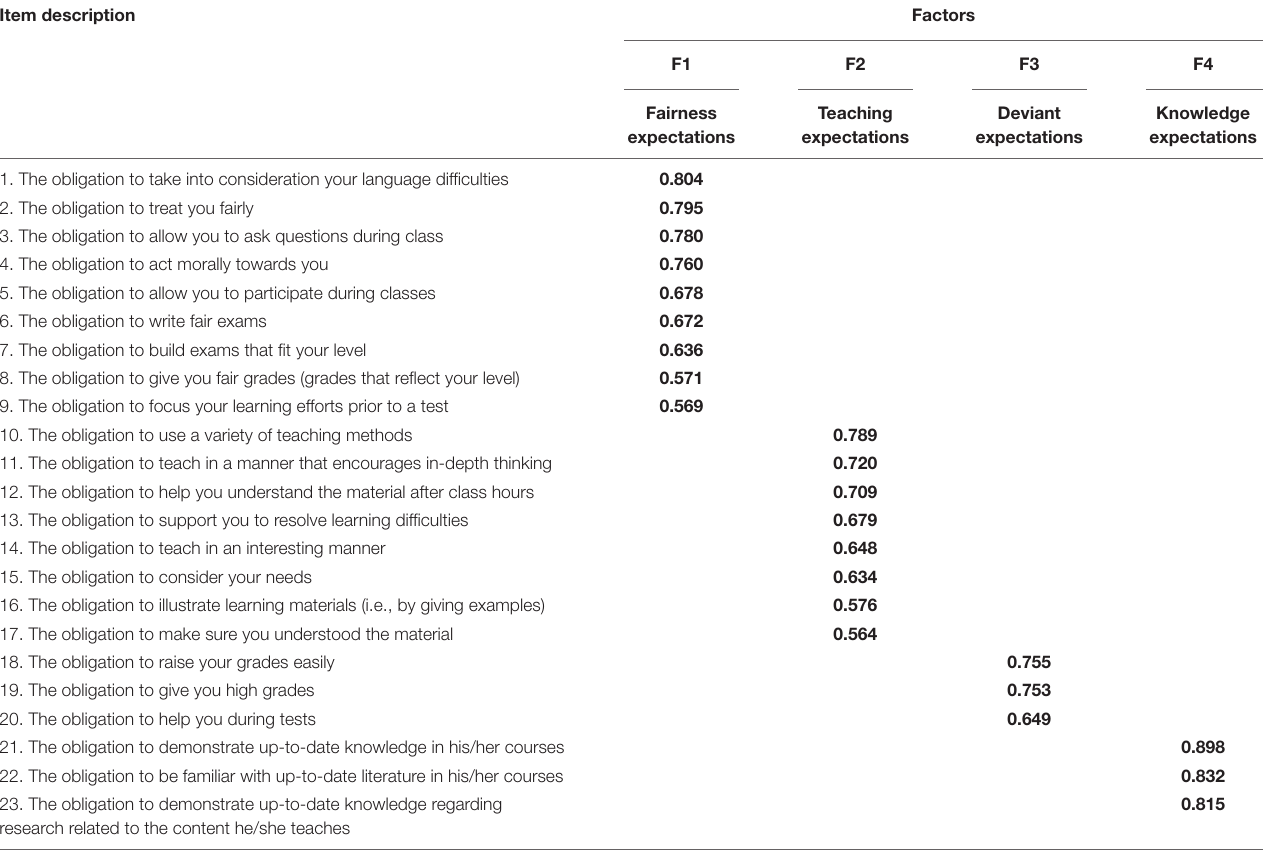
TABLE 2 | The SPCV EFA: factors, item descriptions, and item loadings (in bold). Item